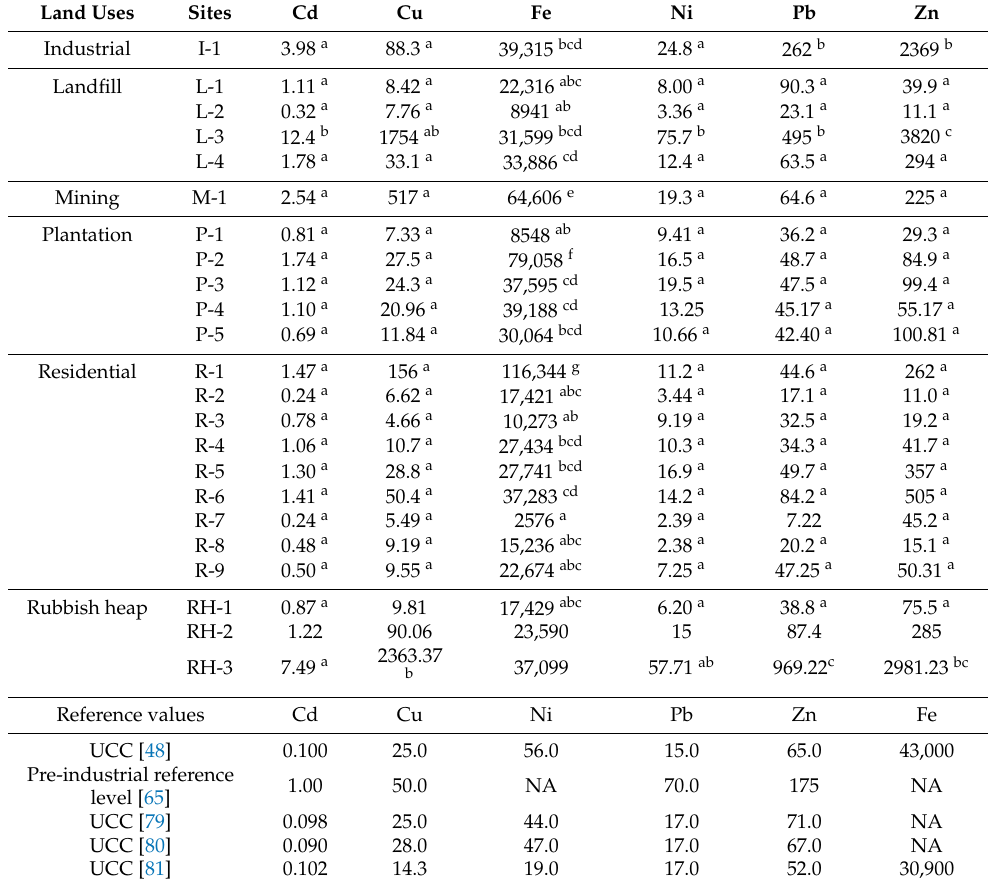
Table 4. The mean of potentially toxic metal concentrations (mg/kg dry weight) in topsoils sampled in Peninsular Malaysia and their comparisons with pre-industrial reference levels and upper continental crust (UCC)